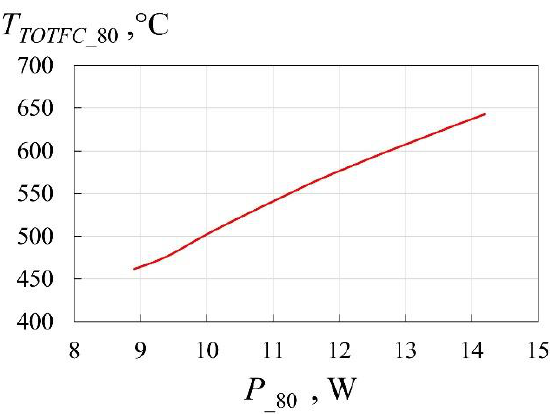
Figure 5. The dependence of T TOTFC_ 80 on P _80 at varied traction speed ( ν ) (the wavelength of laser radiation is 980 nm, the inner vein diameter is 5 mm).